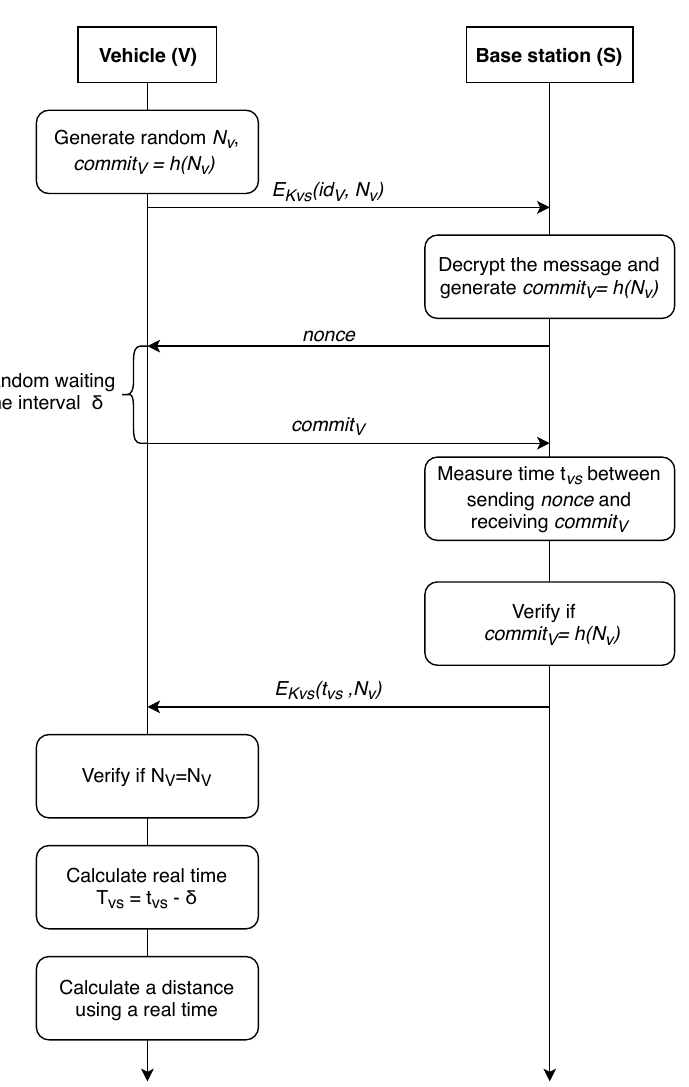
Figure 7. A distance-bounding P-AF-V protocol with the property of anonymity (calculations are made on the vehicle